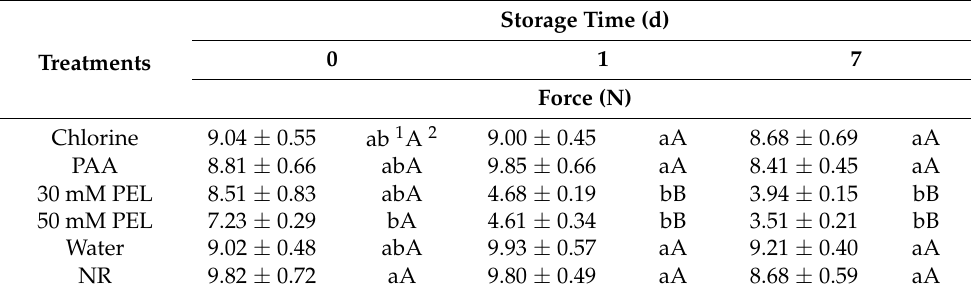
Table 3. Effect of the interactions among sanitizer treatments (including water and no rinse (NR) controls) and storage time on tomato skin penetration (N; n =